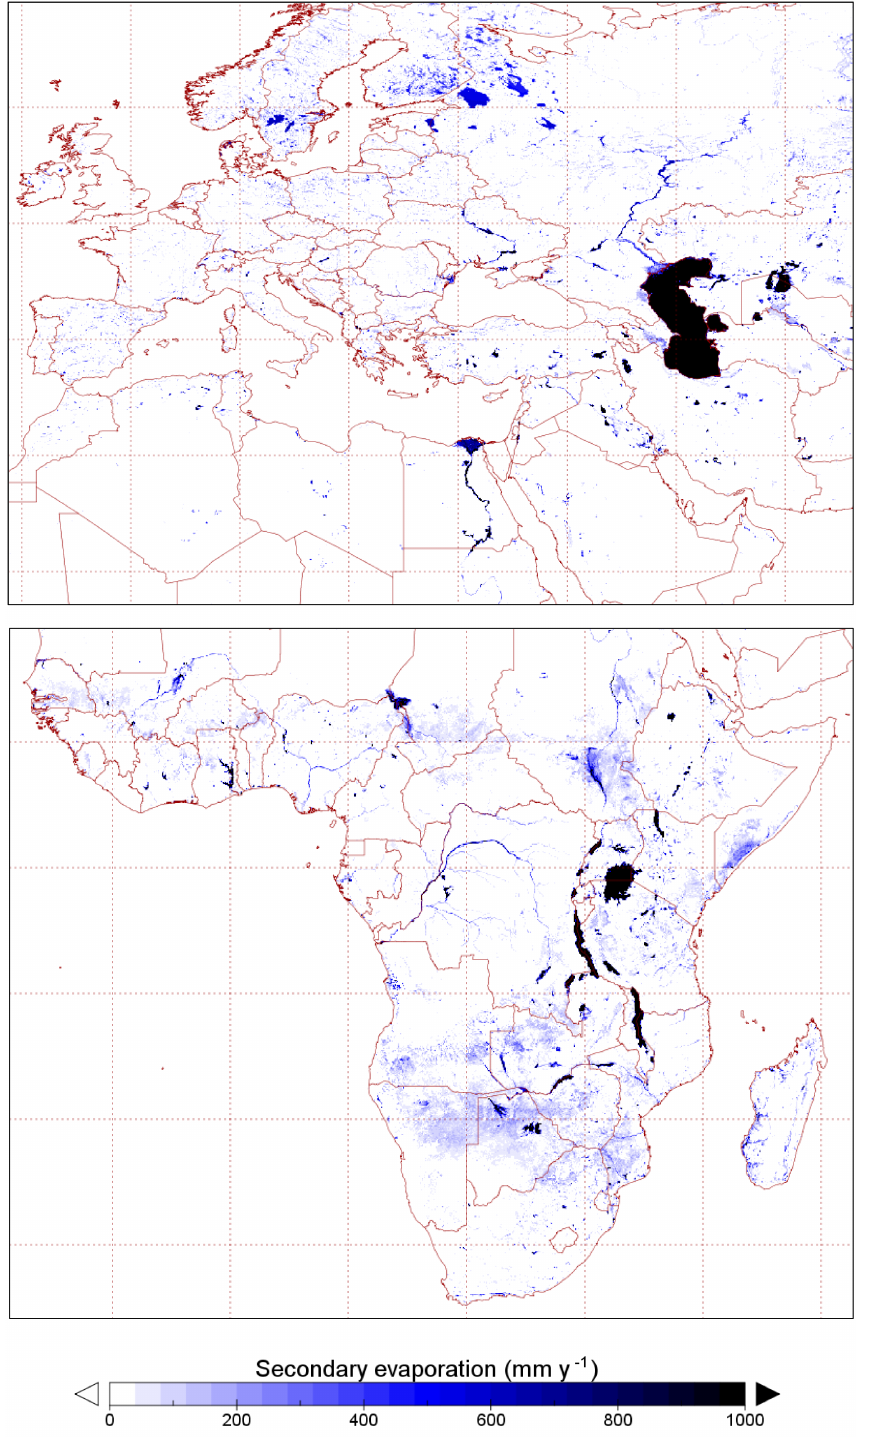
Figure 9. Spatial distribution of secondary evaporation losses in Eurasia and